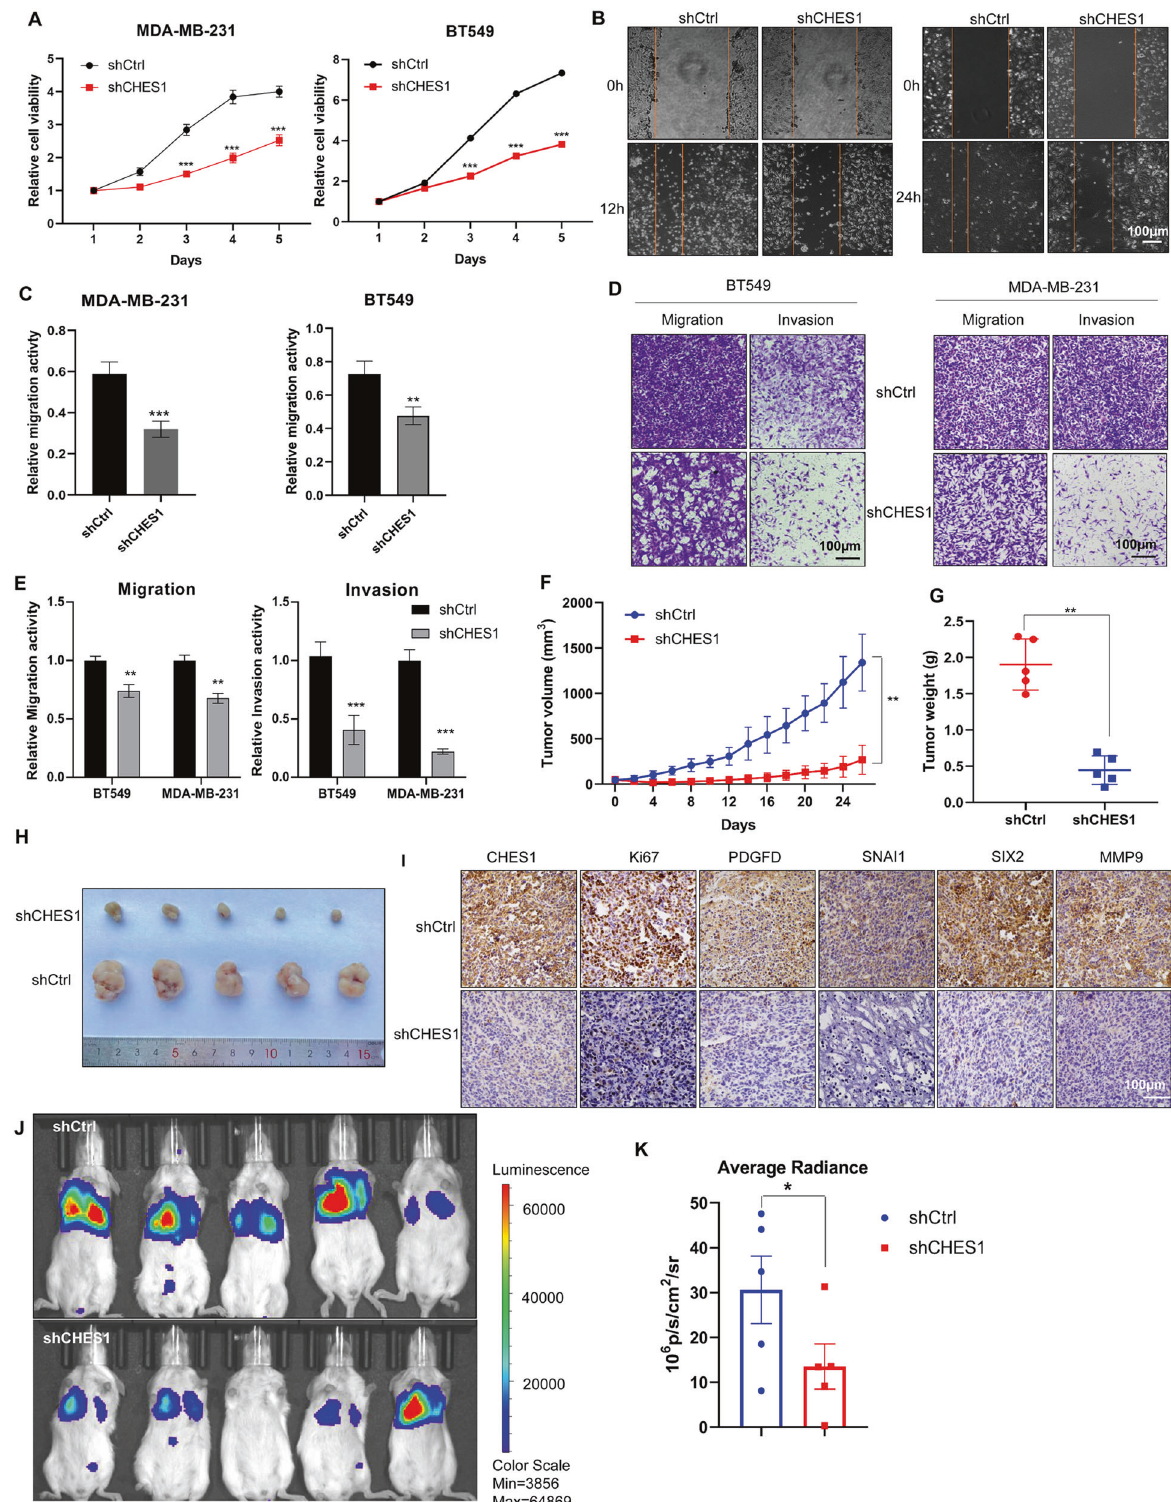
by H&E staining of lung in mice revealed that most metastatic lesions were detected in shCtrl groups, followed by shCHES1 + WT overexpression, and shCHES1 + KR mutant, whereas shCHES1 mice exhibited minimal metastatic events (Fig. 6K). In summary, we showed that acetylation of CHES1 mediated tumorigenesis and metastasis of TNBC via gain-of-function in vitro and in